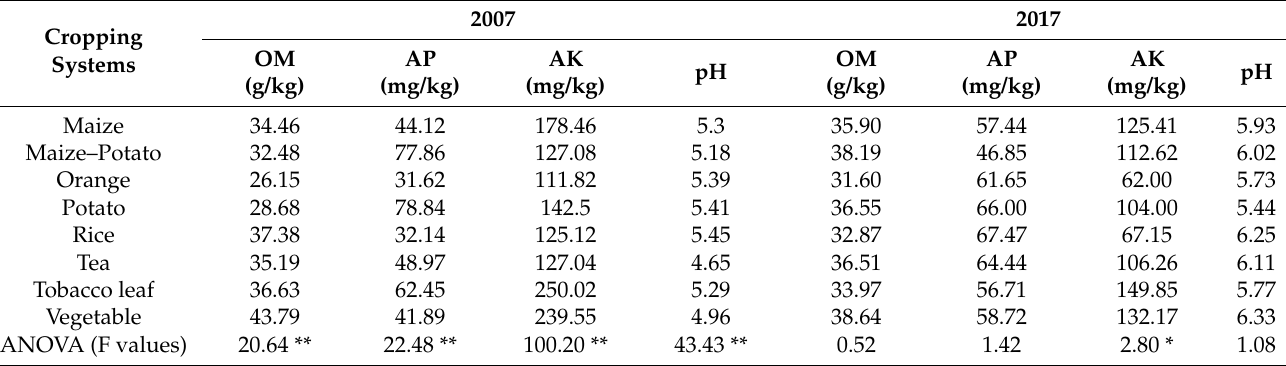
Table 7. Difference significance tests of soil properties between two crop years (2007 and 2017) and eight cropping systems.